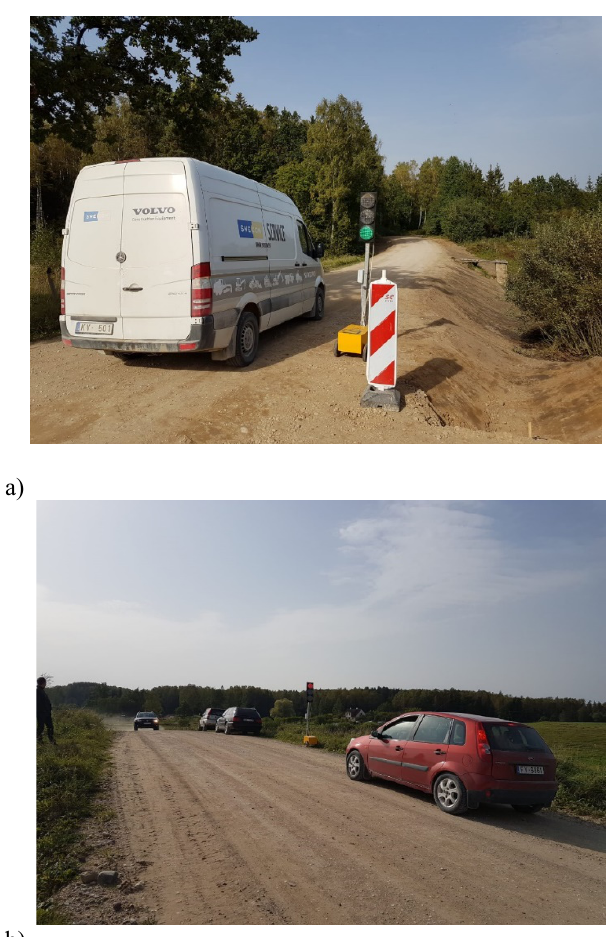
Fig. 13. Traffic light operation testing in case of